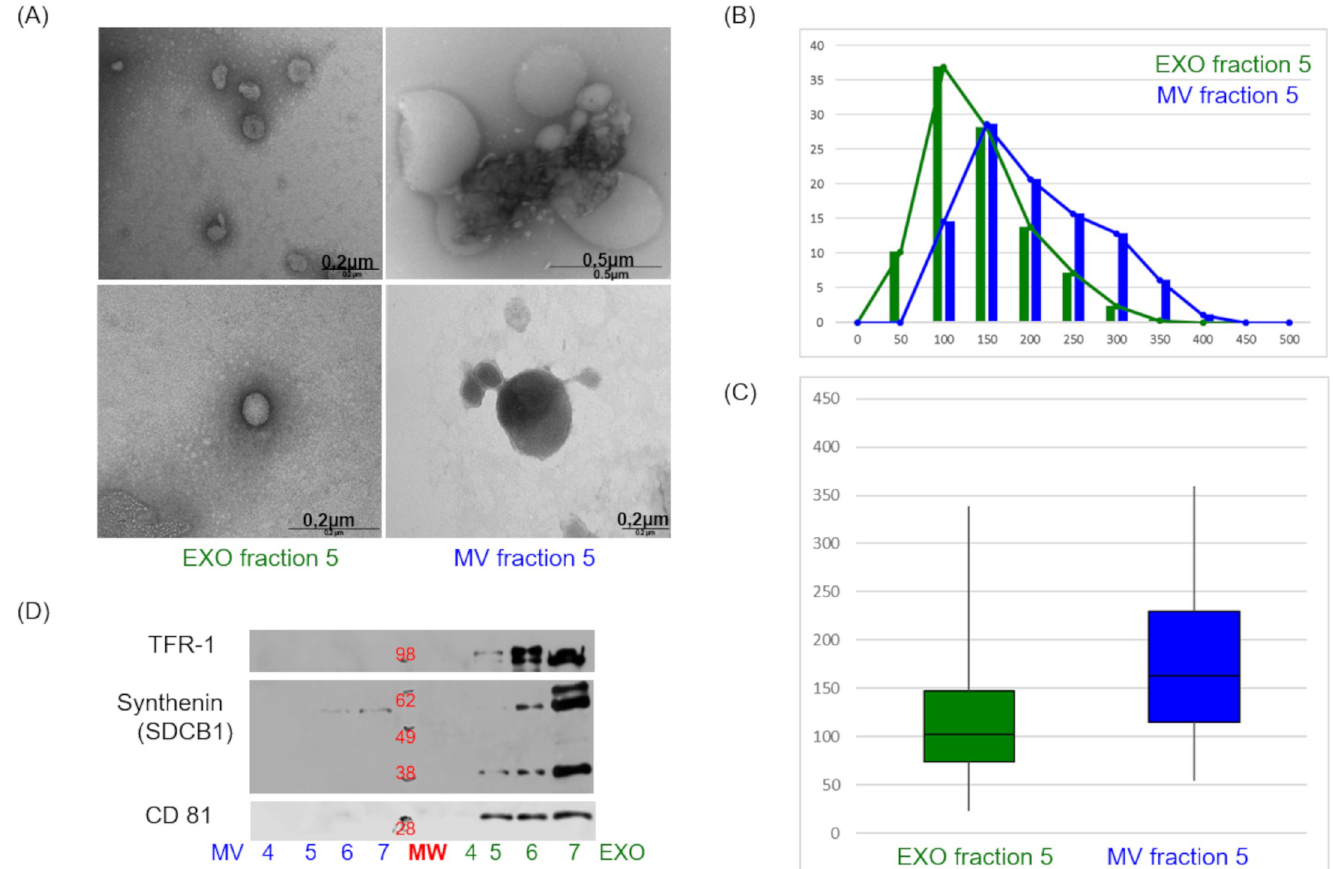
Fig 2. Exosome quality control. Biochemical characterization of EVs isolated from plasma pools from healthy subjects. (A) About 20% of sample volume from gradient fractions EXO/MV 5 was fixed for TEM analyses. (B) The diameter size distribution of particles is shown in percentage of total particles number and (C) in box-plot diagram. The median value of exosome diameter was 102 nm, while that of microvesicles was 158nm. (D) WB analysis of exosome markers CD81 (1:400), Synthenin (1:400), TFR 1 (1:1000), exposition time 1